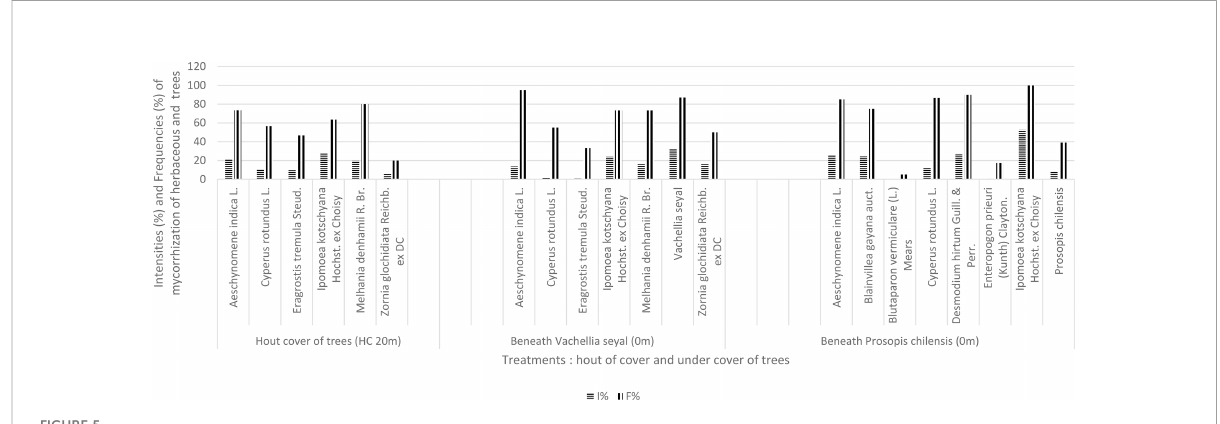
FIGURE 5 Contribution of herbaceous and tree species to FM and IM (VS, Vachellia seyal ; PS, Prosopis chilensis